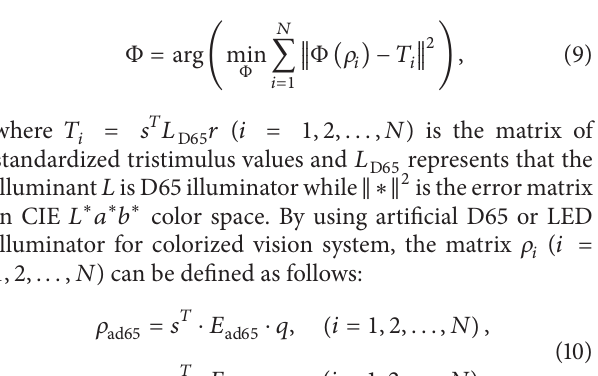
continuous spectra by their values at a number of discrete sample points; thus (5) can be transformed to the below